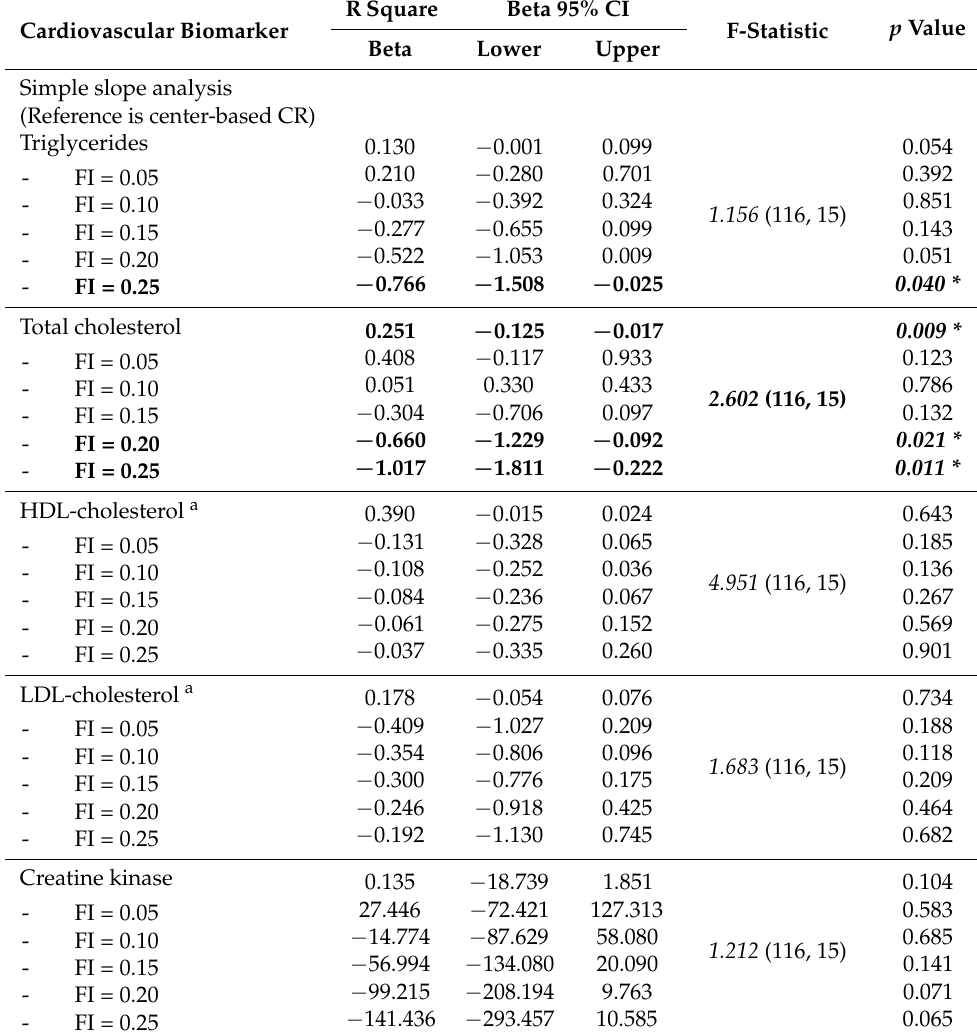
Table 2. Simple slope analyses of cardiovascular biomarker change by admission CLSA-FI b and CR program model